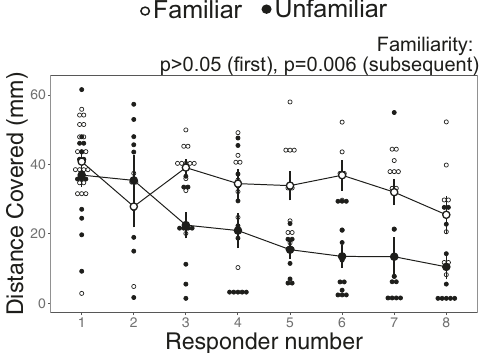
Fig. 4 The distance covered during the fast-start escape response in familiar versus unfamiliar schools of the damsel fi sh Chromis viridis . Distance covered (i.e. the distance moved during the fi rst 42 ms of the reaction, the mean time period for individuals to complete two body bends known as stages 1 and 2) by responder number (the sequential order of responses in each fi sh ’ s respective group). This trait is indicative of the escape response ’ s speed and acceleration ( n = 24 schools, composed of 8 fi sh each). Each larger dot represents the mean ± s.e., with small dots indicative of individual data